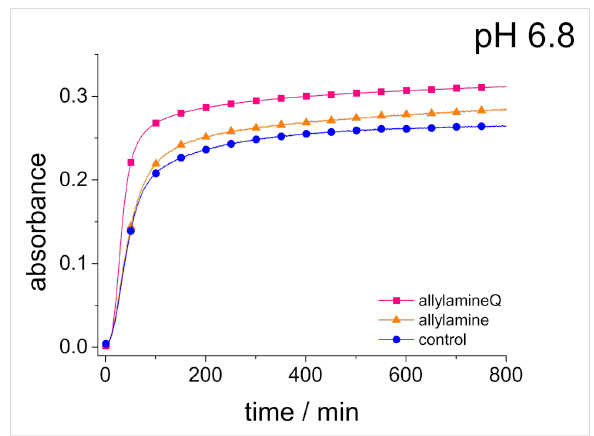
Figure 5: Absorbance of a 90 mM sodium metasilicate solution with 10 mM allylamine (orange triangles), 10 mM allylamineQ (pink squares) and of a sodium metasilicate solution (control, blue circles) measured as a function of time up to 800